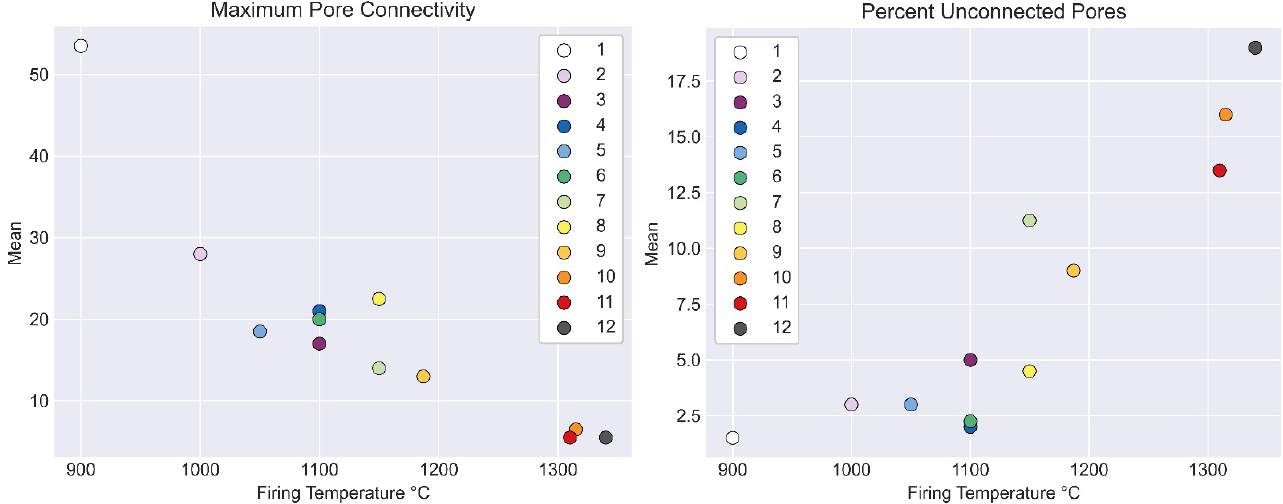
Figure 14. Maximum pore connectivity mean values ( left ) go down with increased firing temperature, indicating more isolated unconnected pores form in the higher-fired ceramic products. This situation is also indicated by the fact that the percentage of pores unconnected ( right ) is shown to rise with higher firing temperatures. Points are mean of 2.